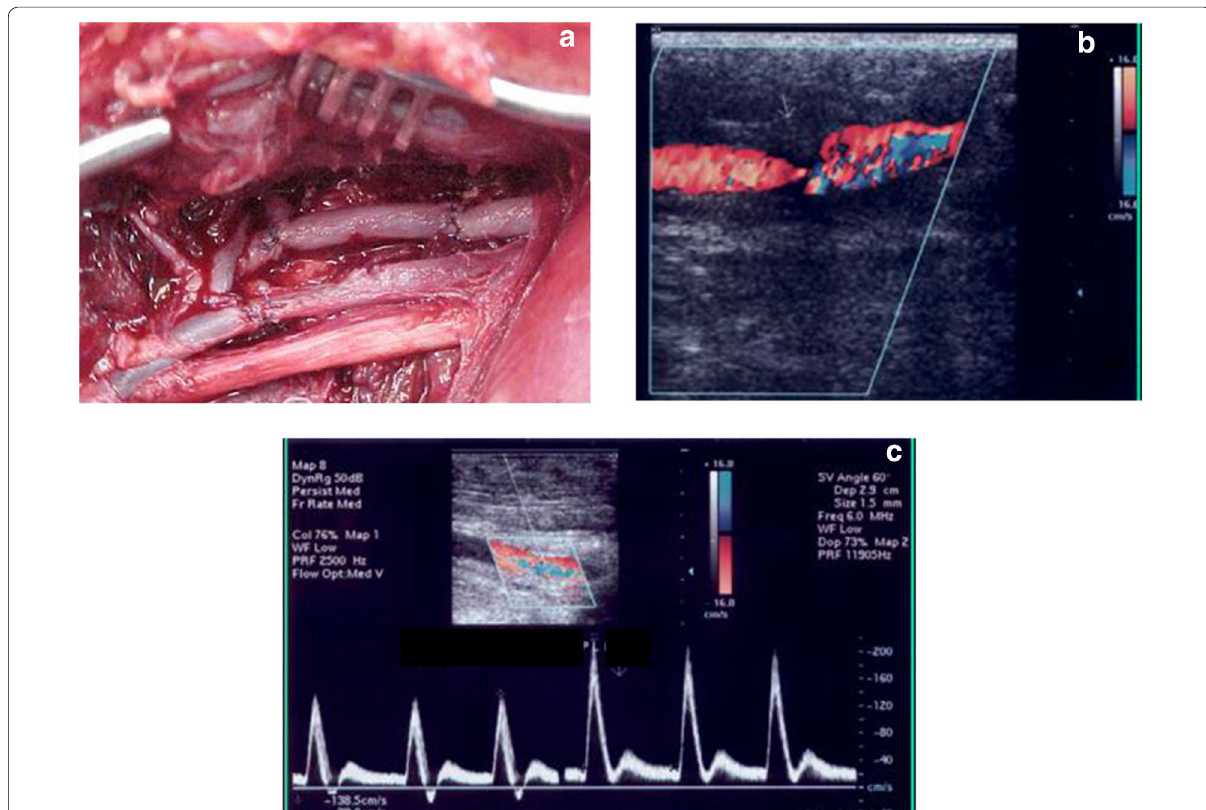
Fig. 21 Gun shot femoral artery injury. Post operative follow up. a Surgical repairment with vein interposition. b Color flow: stenosis with turbulent flow in the anastomosis. c Increase of the velocity at the level of the stenosis in the pulsed Doppler